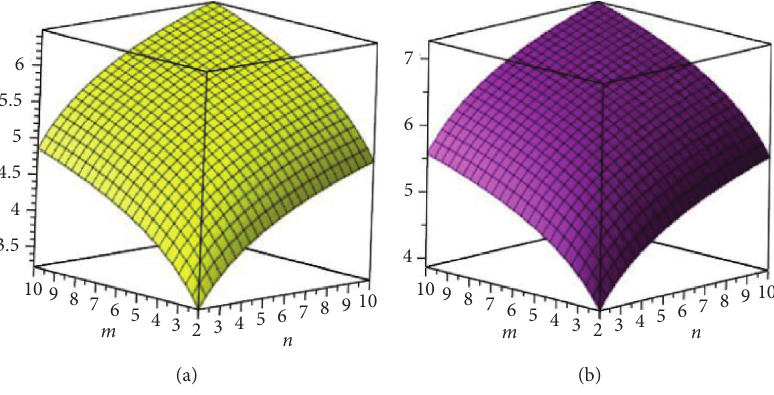
Figure 20: (a) The ABC